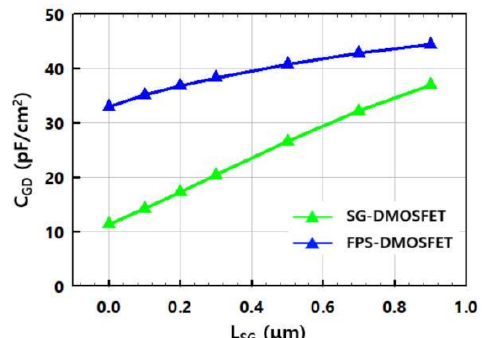
Figure 4. Comparison of C GD (gate-to-drain capacitance) values of SG-DMOSFET (split-gate DMOS- FET) and FPS-DMOSFET (floating p+ polysilicon split-gate DMOSFET) according to L SG (active gate length) change.